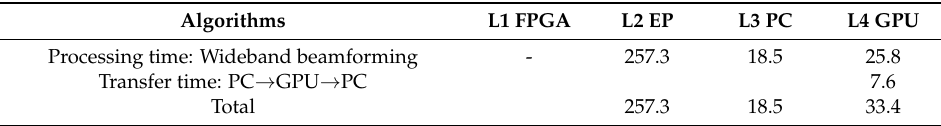
Table 3. Processing and transfer times 1 for wideband beamforming.